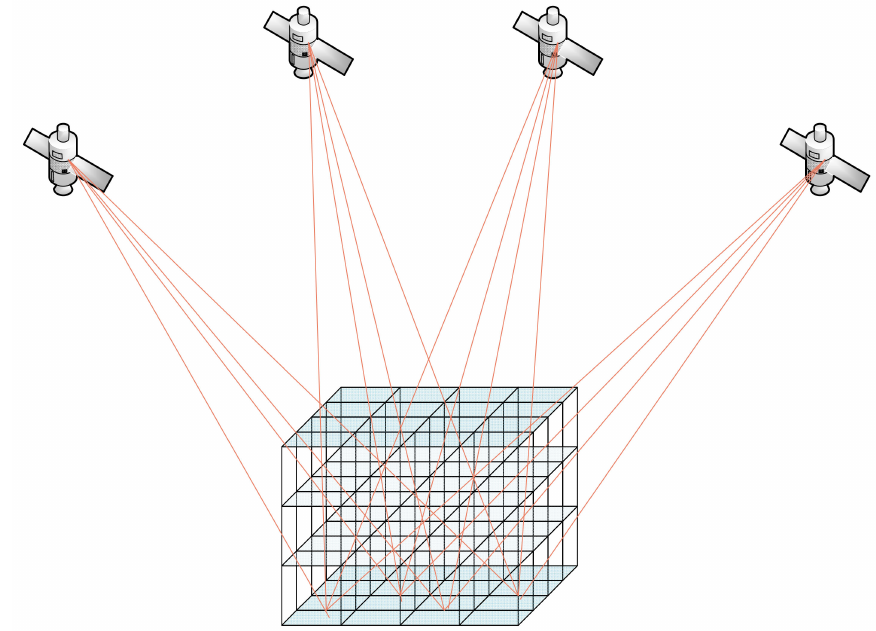
Figure 1. Principle of water vapor (WV) tomography with Global Navigation Satellite System (GNSS)